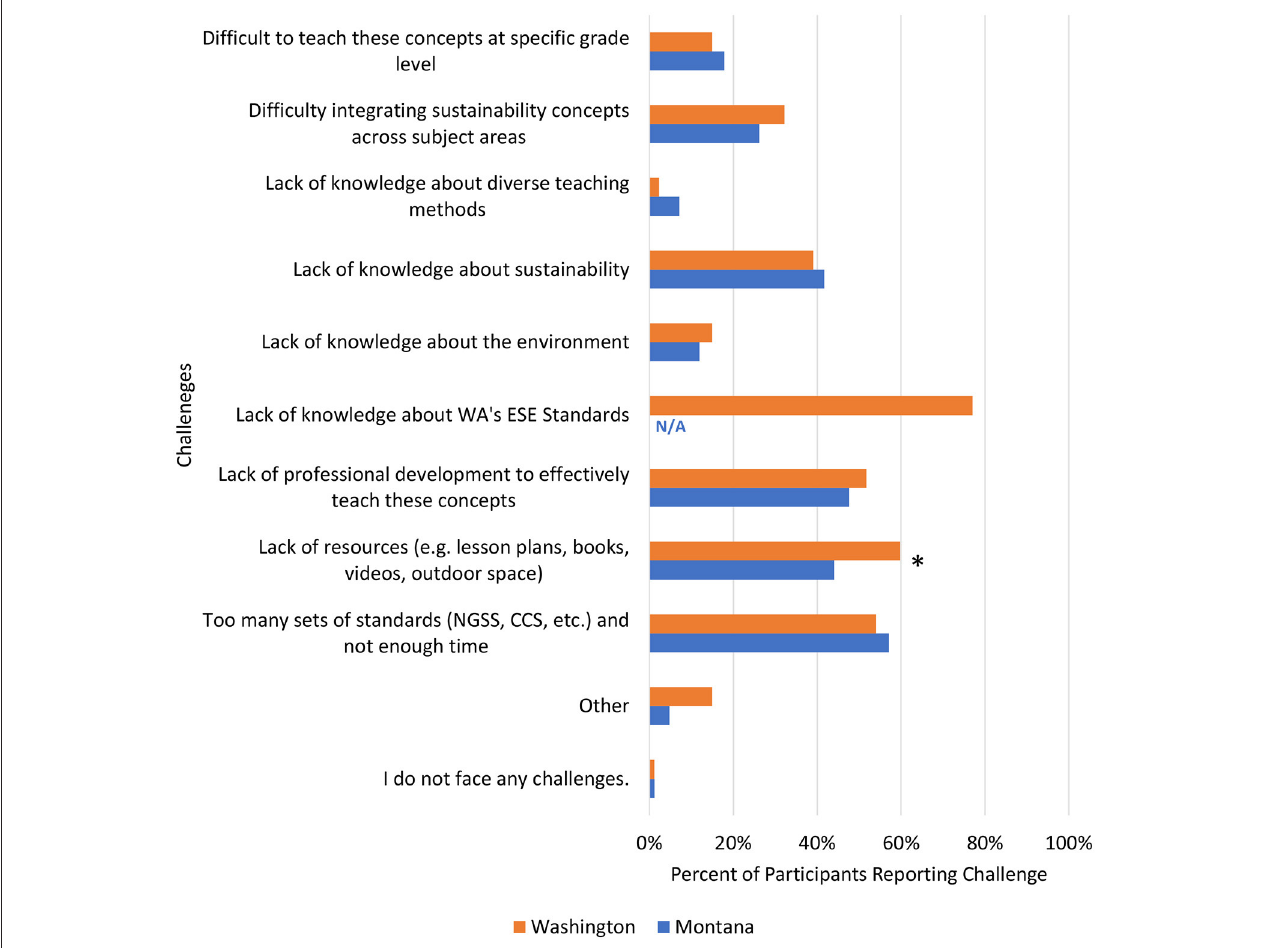
FIGURE 4 | The percent of participants from Washington ( n = 87) and Montana ( n = 84) that report facing each challenge when trying to teach about sustainability in their classrooms. Asterisks represent significant